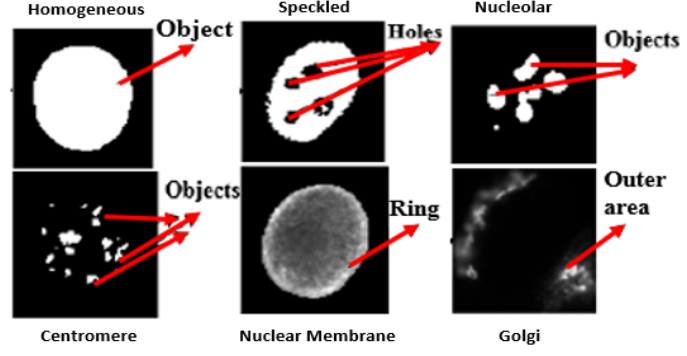
Figure 6. Unique characteristics of each